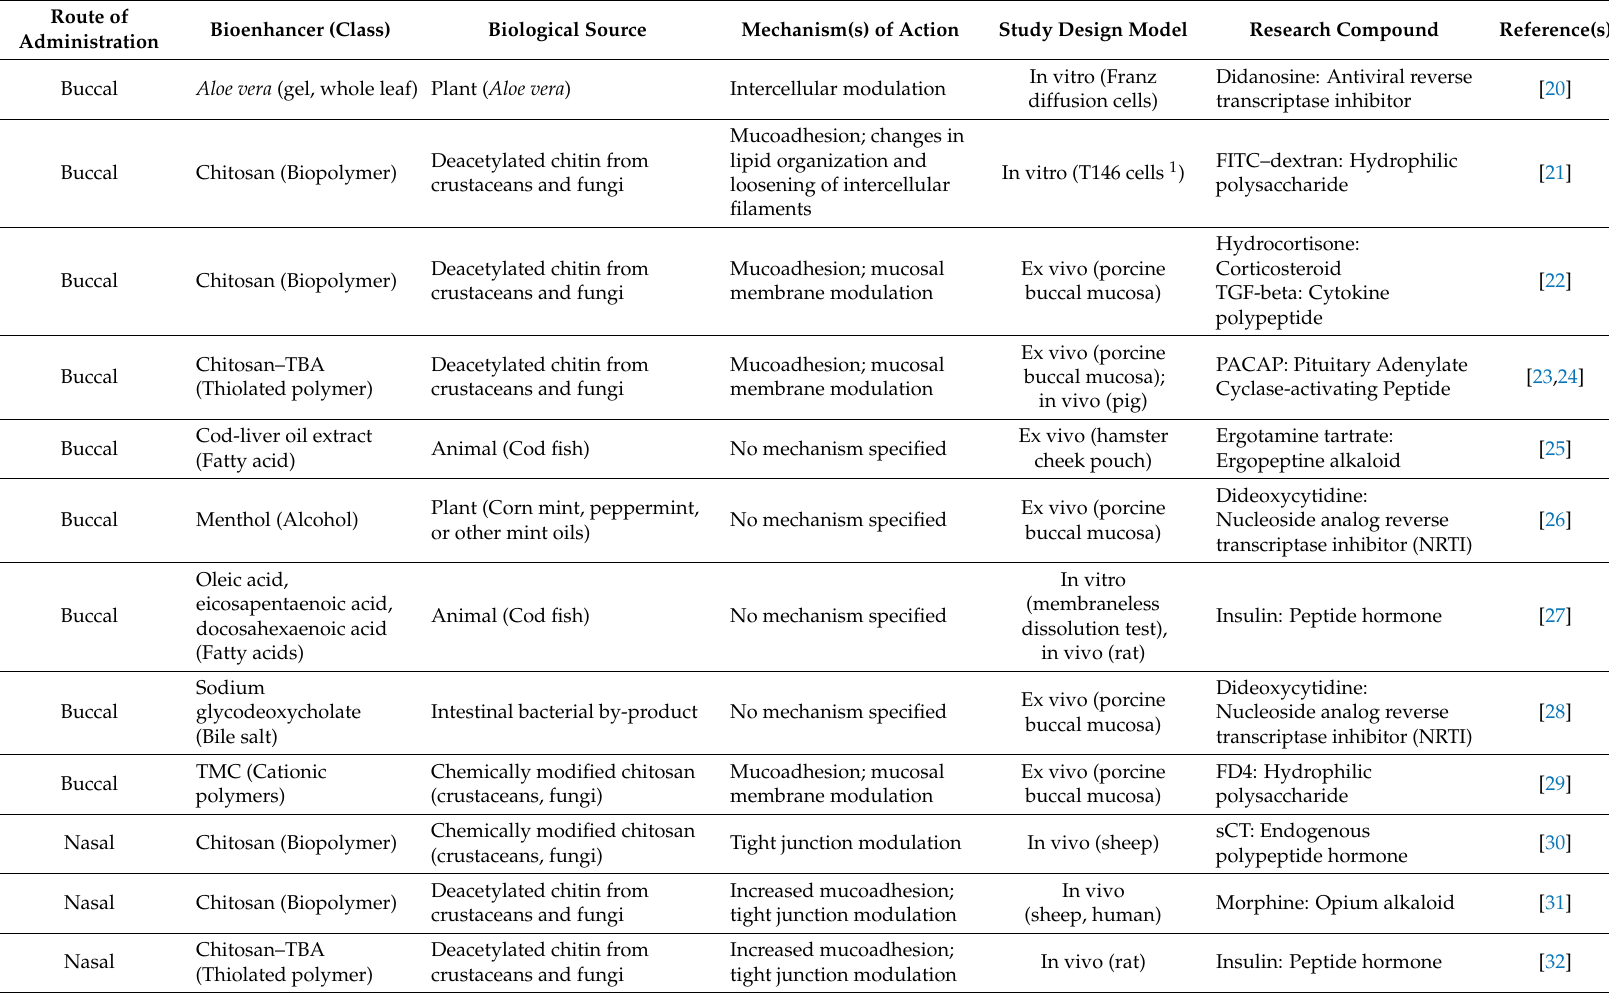
Table 1. Summary of selected natural bioenhancers and their main mechanisms of action on various drugs for enhanced nasal, oral, buccal and pulmonary drug